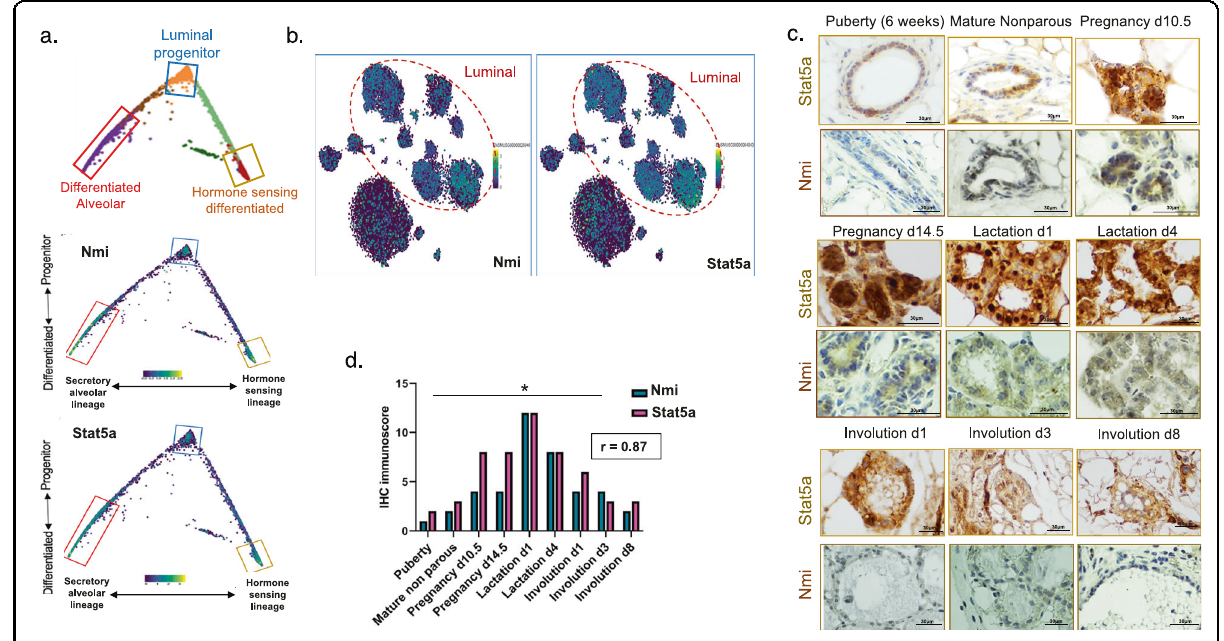
Fig. 1 NMI and STAT5A show concurrent expression pattern during mammary gland differentiation. a NMI and STAT5A expression within computational reconstruction of the luminal compartment generated from single-cell RNA-seq mouse mammary cells different stages of differentiation. b t-distributed stochastic neighbor embedding (t-SNE) overlaid NMI and STAT5A expression in different Luminal and Basal clusters. c Immunohistochemical staining for STAT5A and NMI on mouse mammary tissues during different stages of development (puberty, mature non parous, pregnancy d10.5, pregnancy d14.5, lactation d1, lactation d4, involution d1, involution d3, and involution d8). d IHC immunoscore for STAT5A and NMI staining on mouse mammary tissues during differentiation. Expression was the highest during pregnancy and lactation, then